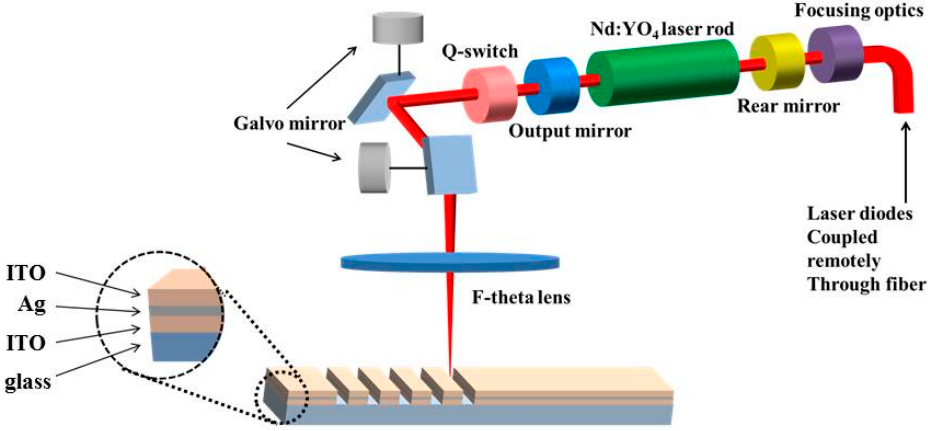
Figure 1. Schematic diagram of experimental setup for laser direct ablation of ITO/Ag/ITO MLs on glass substrates.